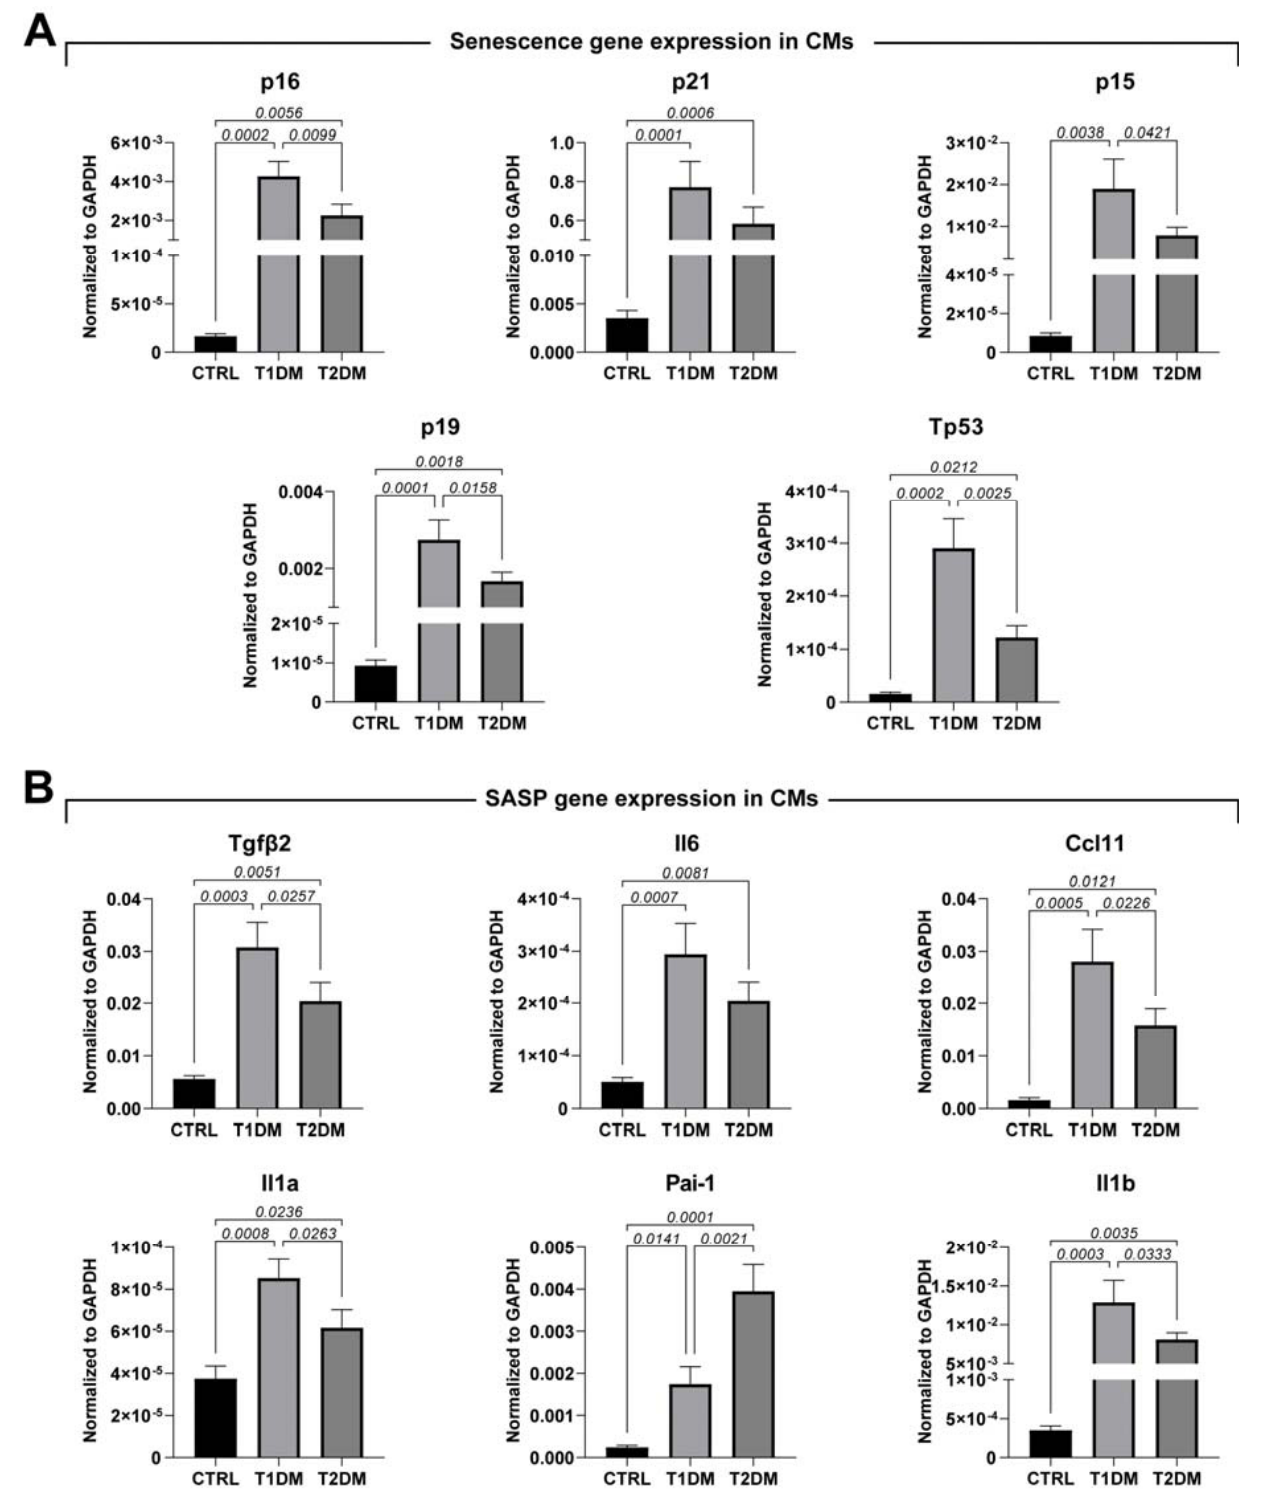
Figure 5. STZ-based T1DM and T2DM mouse models affected cardiac cell senescence differently. ( A , B ) Bar graphs showing the expressions of senescence and SASP markers in cardiomyocytes isolated from CTRL, T1DM and T2DM mice (n = 3). Data are mean ±